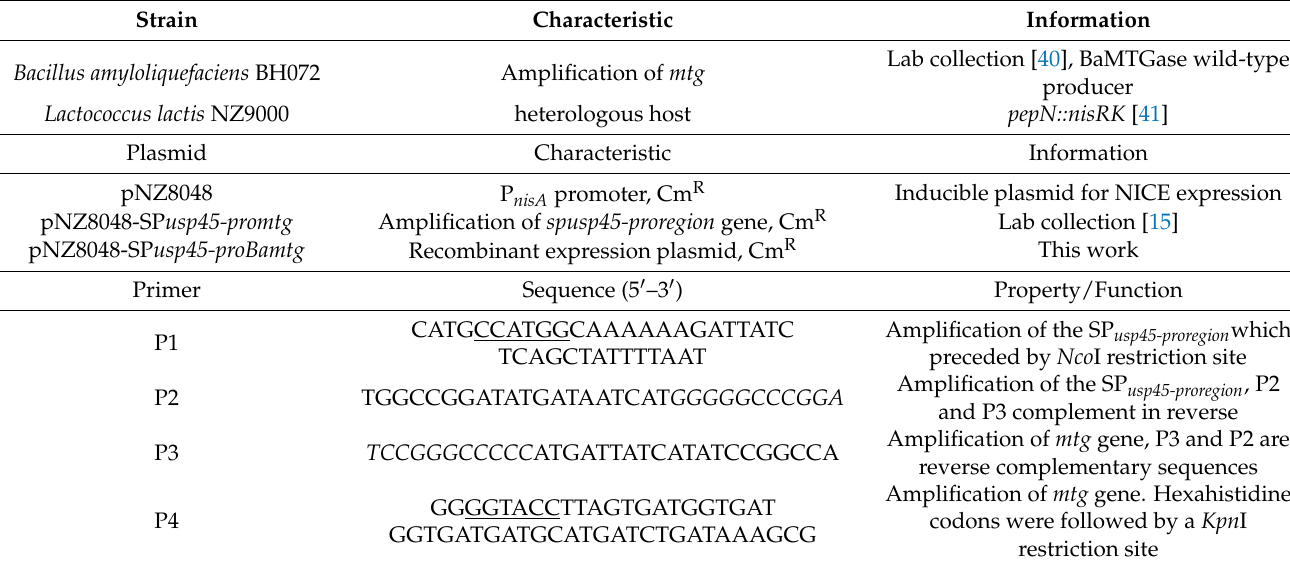
Table 4. Strains, vectors and primers used in this